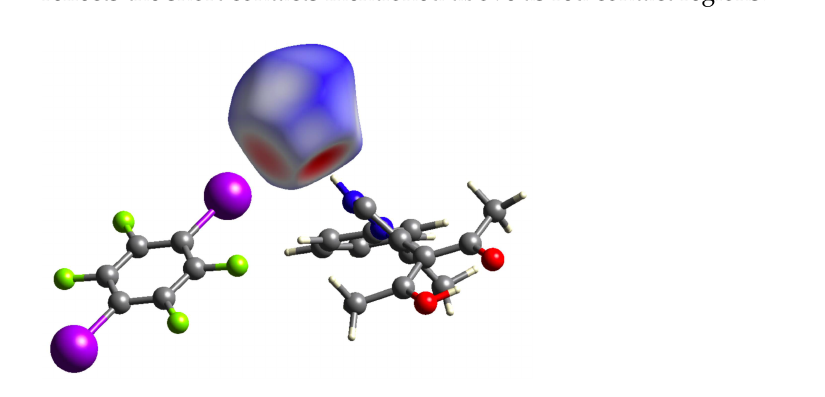
Figure 7. Hirshfeld surface [46] around Cl1 mapped with d norm ; regions marked in red represent directions of short, those in blue of long contact